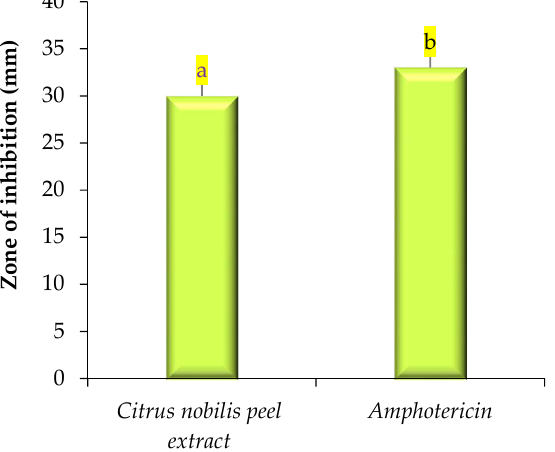
Figure 3. Antifungal activity (zone of inhibition) of Citrus nobilis peel dry extract against Candida albicans. Data are presented as means ± SEM ( n = 3); a,b: Means within the column with different lowercase superscripts are significantly different ( p < 0.05).